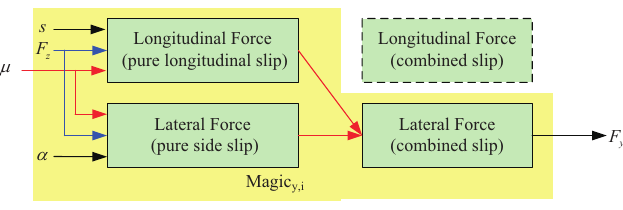
Figure 8. Structure of the Magic